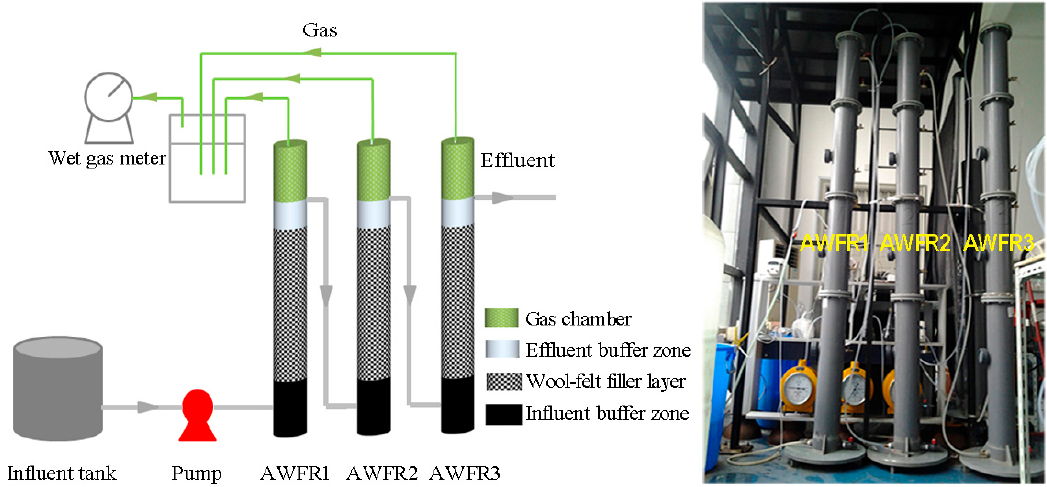
Figure 1. Schematic diagram and photo of the anaerobic wool-felt filter reactor (AWFR). Table 1. The main operating conditions for the anaerobic wool-felt filter reactor (AWFR) system during the five operation stages.